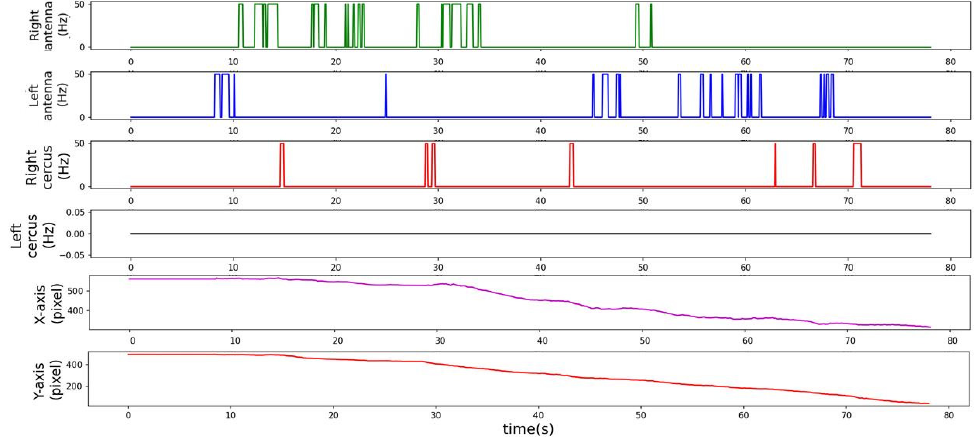
Figure 12. Cockroach position response for path following trajectory commanded from Bangladesh.